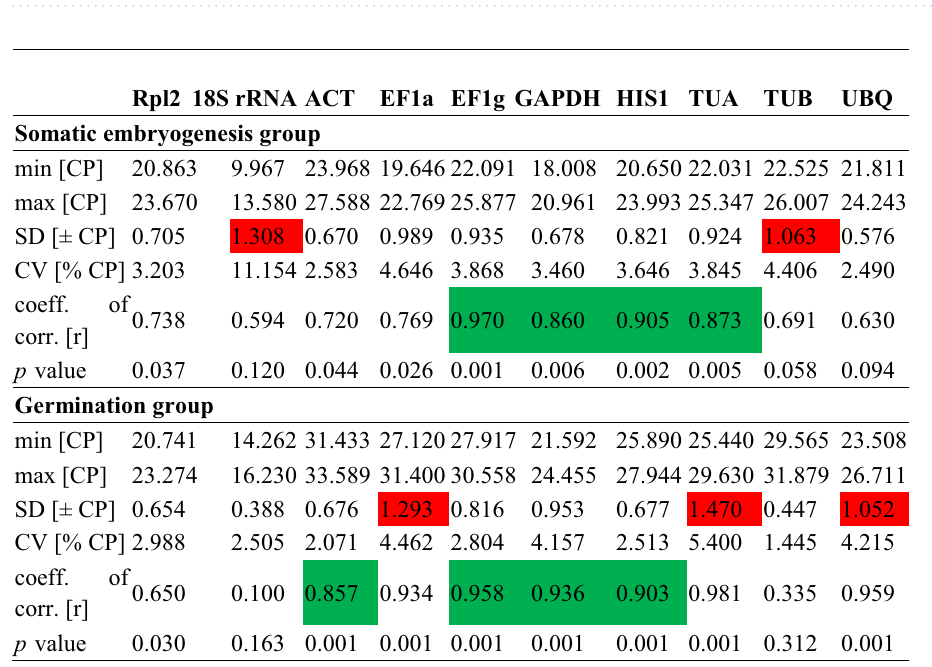
Table 2. BestKeeper software statistics for reference genes based on Ct values in the somatic embryogenesis and the germination groups. CP equivalent terminology for Ct, standard deviation (SD; ± CP): the SD of the CP (values greater than 1 are highlighted in red); Coefficient of variance (CV; %CP): the CV expressed as a percentage of the CP level. The correlation between each candidate reference gene and the BestKeeper index was calculated using Pearson’s correlation coefficient (r) (values correlated well are highlighted in green) and the P value 31